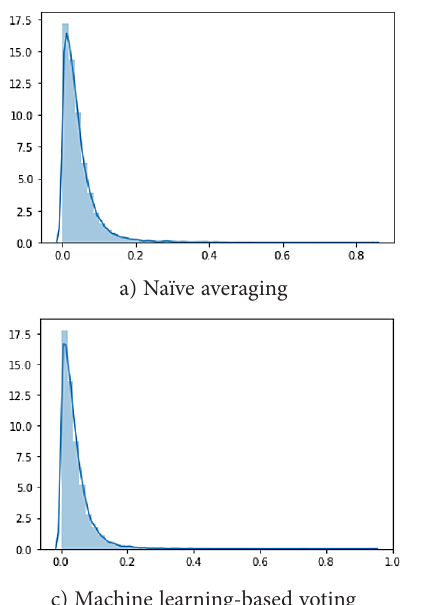
Figure 9. Distribution of prediction errors